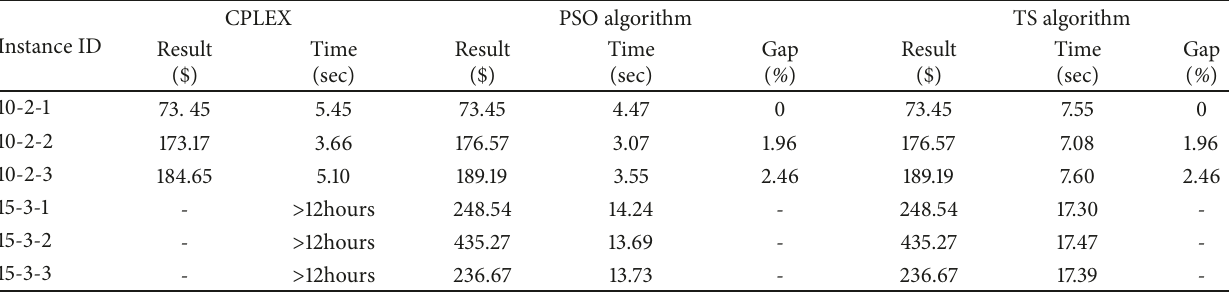
Table 2: Computational results of small-scale instances.